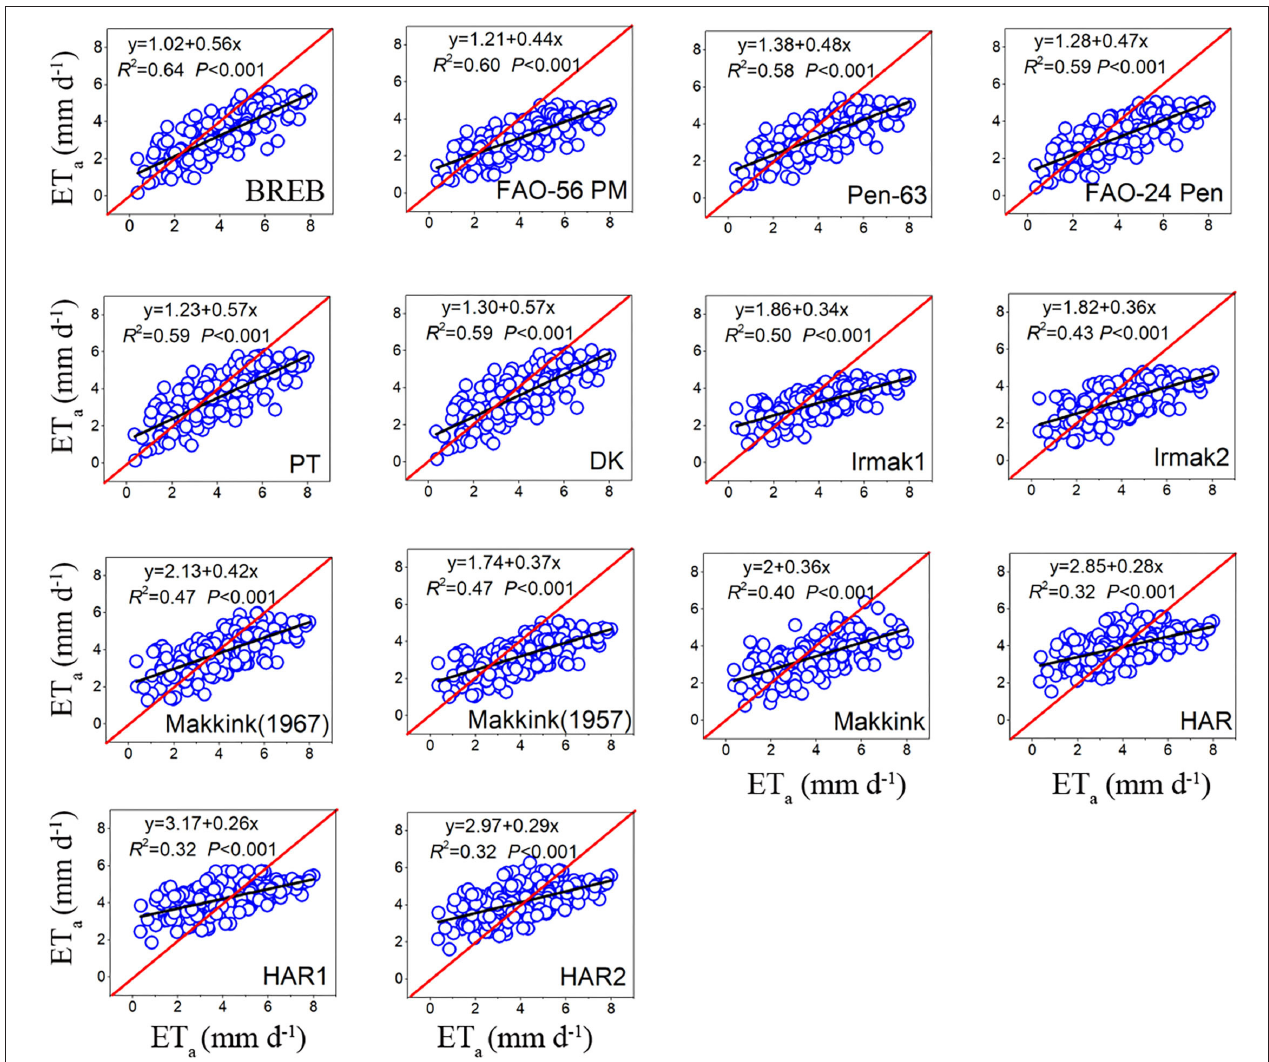
FIGURE 5 | The relationship between daily ET 0 of model estimates and ET a of lysimeter measurements during the growing season (data points =